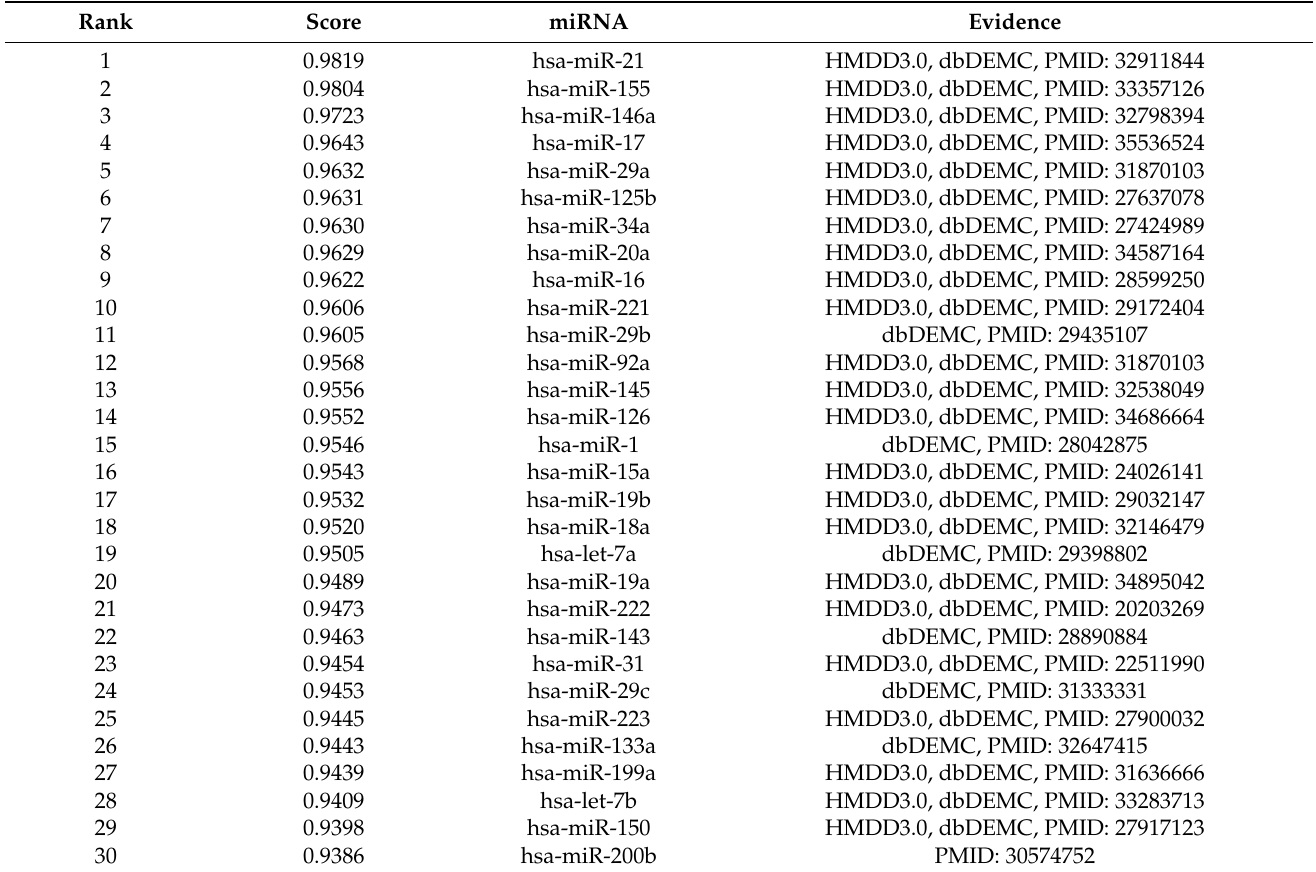
Table 5. Top 30 Predicted Associations of